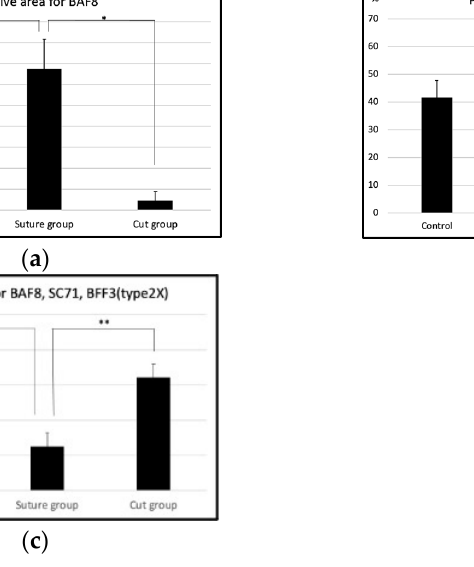
Figure 6. Statistical comparison between the percentage of each muscle fiber type in each group. ( a ) The chart indicates the BAF8-positive areas among the three groups. The suture group showed significantly higher percentages of BAF8 positivity than the other two groups. Its average percentage in the control, suture group, and cut group was 2.92% ± 2.00%, 13.50% ± 2.83%, and 0.92% ± 0.87%, respectively. ( b ) As for BFF3, the cut group revealed significantly lower positivity than the suture group. Its average percentage in the control, suture group, and cut group was 41.52 ± 6.30%, 52.17 ± 8.30%, and 27.99 ± 10.80%, respectively. ( c ) The negative area for BAF8, SC71, and BFF3 was 51.16 ± 6.77% for the control group, 25.00 ± 7.72% for the suture group, and 64.42 ± 7.68% for the cut group. (* p < 0.01, ** p < 0.05, n = 4 for each group, one-way ANOVA).